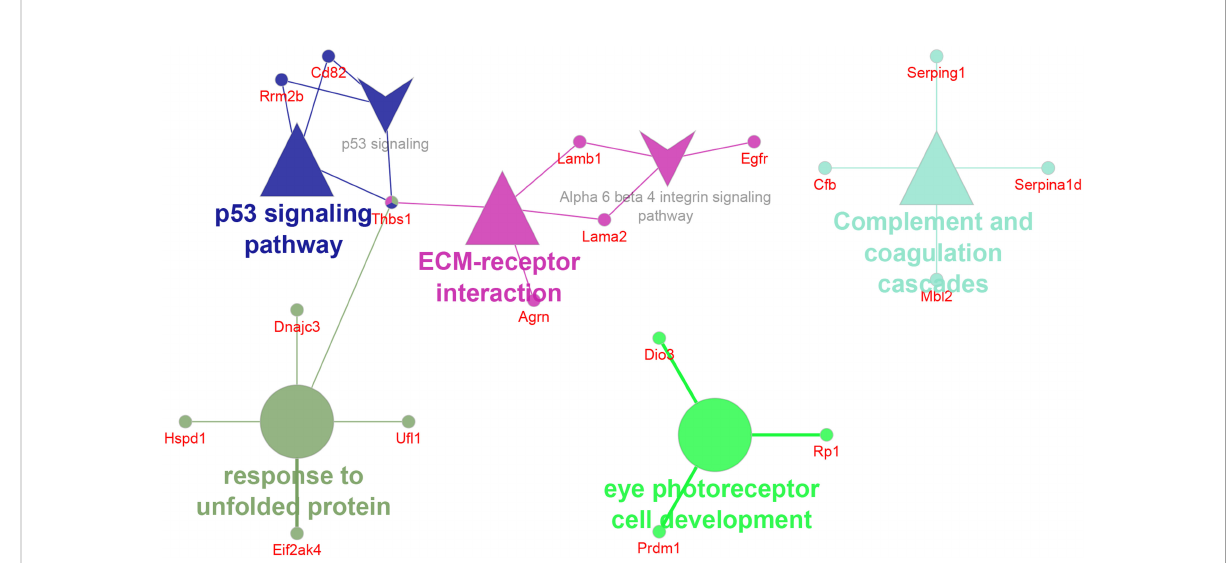
FIGURE 7 Network of GO terms, pathways and associated genes unique to F5-10 WT EV. The network has been created using the ClueGO and Cluepedia applications of Cytoscape, with the GO Biological Process GO Cellular Component, GO Molecular Function, KEGG and Wiki Pathways; pV <